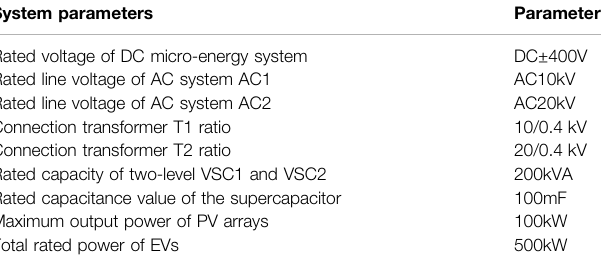
TABLE 1 | System parameters. System parameters